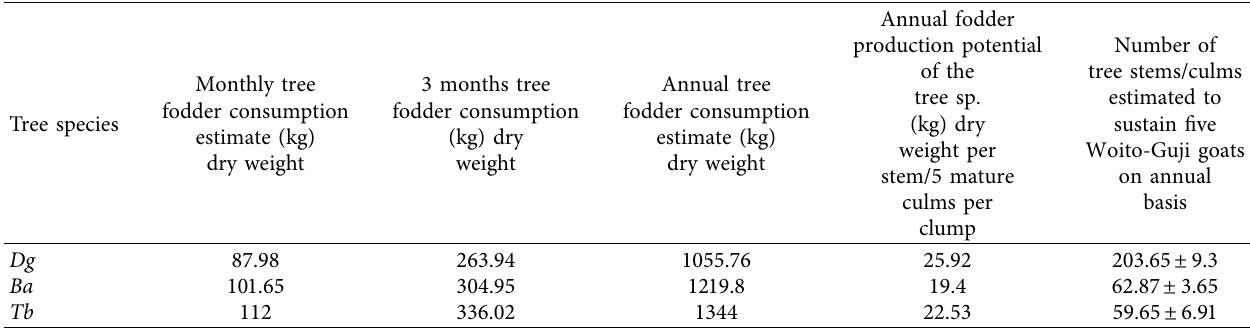
Table 2: Estimate of the tree stems and culms required to sustain fve Woito-Guji goats on annual basis in addition to the basal hay forage supply.